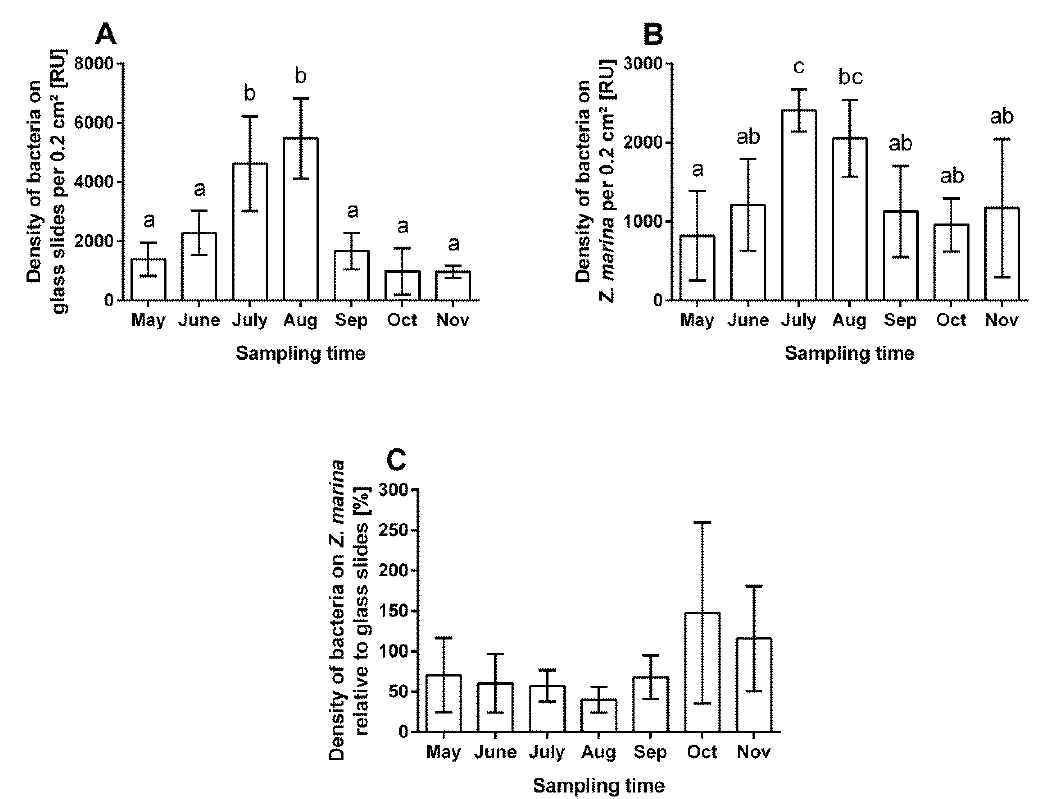
Figure 1. Seasonal variations of ( A ) bacterial fouling pressure (measured as bacterial density on glass slides); ( B ) bacterial density on Z. marina ; and ( C ) bacterial density on Z. marina (shown in B) relative to bacterial fouling pressure (shown in A). In (A–C) mean ± SD, n = 4, different letters in single graphs indicate months that are significantly different in Tukey’s post hoc test ( p < 0.05).